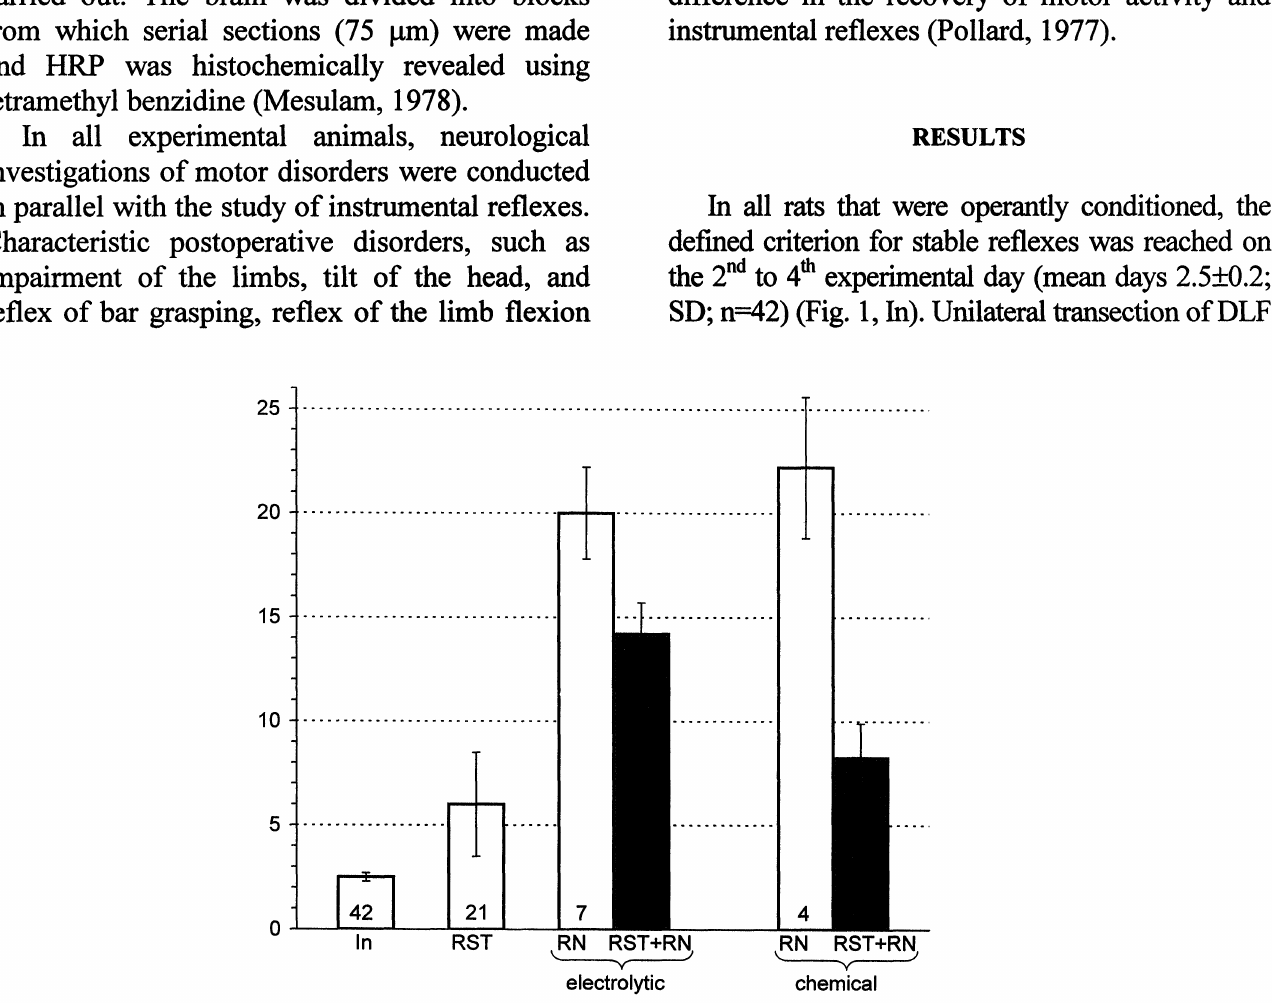
Fig. 1: Histogram comparing mean values +SD from the mean in the number of days required to reach criterion values of performance of instrumental reflexes (ordinate). Abscissa indicates the training of reflexes in intact rats (In), after transection of the dorsolateral funiculus (here called the rubrospinal tract, RST), electrolytic lesion red nucleus (RN) alone, transection of RST and subsequent electrolytic lesion of RN (RST+RN, electrolytic), chemical lesion of RN alone (RN), transection of RST and subsequent chemical lesion of RN (RST+RN, chemical). The numerical value within each column indicates the number of rats in this series of